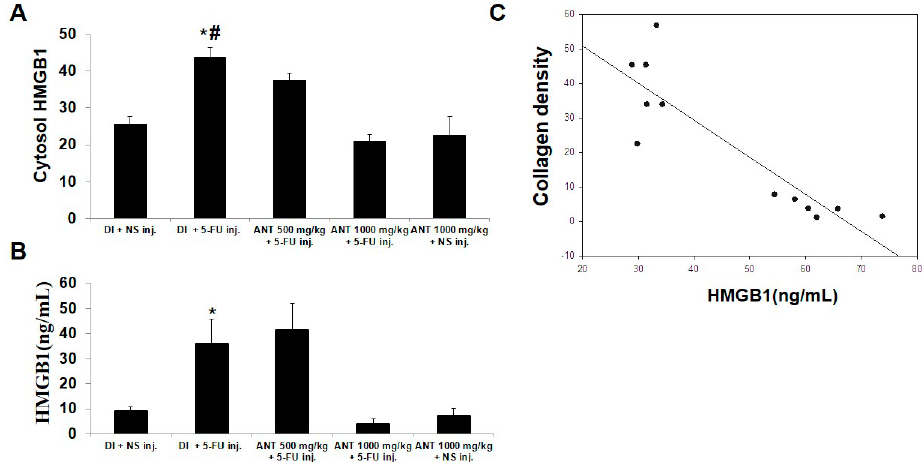
Figure 6. The Evaluation of cytosolic and serum high mobility group box 1 (HMGB1) in 5-FU-induced oral mucositis. ( A ) Immunohistochemical analysis of cytosolic HMGB1 expression in the oral mucosa. The number of HMGB1-positive cells per field in the lesion have been count. * p < 0.05 vs. 500 mg/kg ANT-rich extract fed with 5-FU injection, # p < 0.001 vs. DI fed with normal saline (NS) injection; ( B ) serum HMGB1 levels were evaluated by ELISA. Data are expressed as the mean ± S.D. ( n = 6). * p < 0.001 vs. 1000 mg/kg ANT-rich extract fed with 5-FU injection; ( C ) Correlation of the levels of collagen in the buccal mucosa and serum HMGB1.